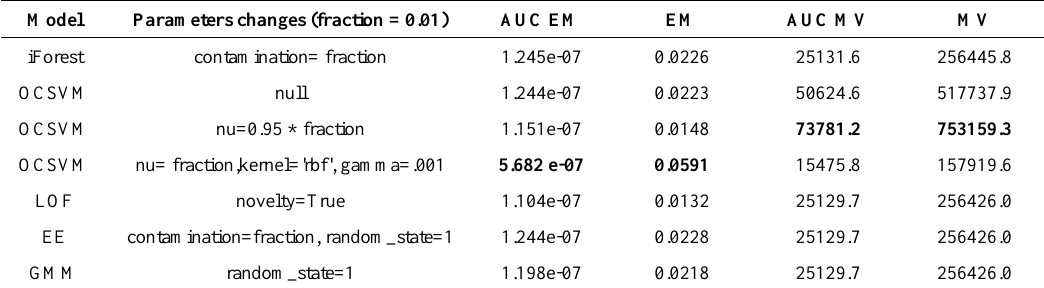
Table 1. Results for the novelty detection setting without PCA, where n_features=1.